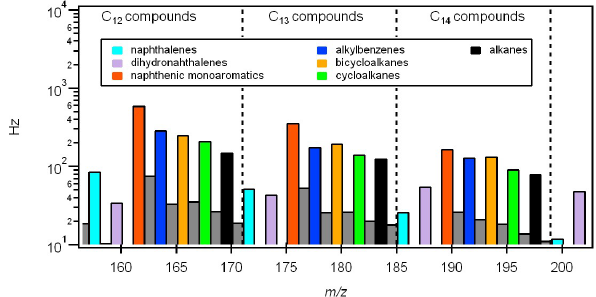
Fig. 5. Examination of the C 12 –C 14 compound range ion signal pattern for diesel fuel. Peaks have been tentatively identified as be- longing to 1 of 7 compound groups that differ by the degree of un- saturation, ranging from naphthalenes to